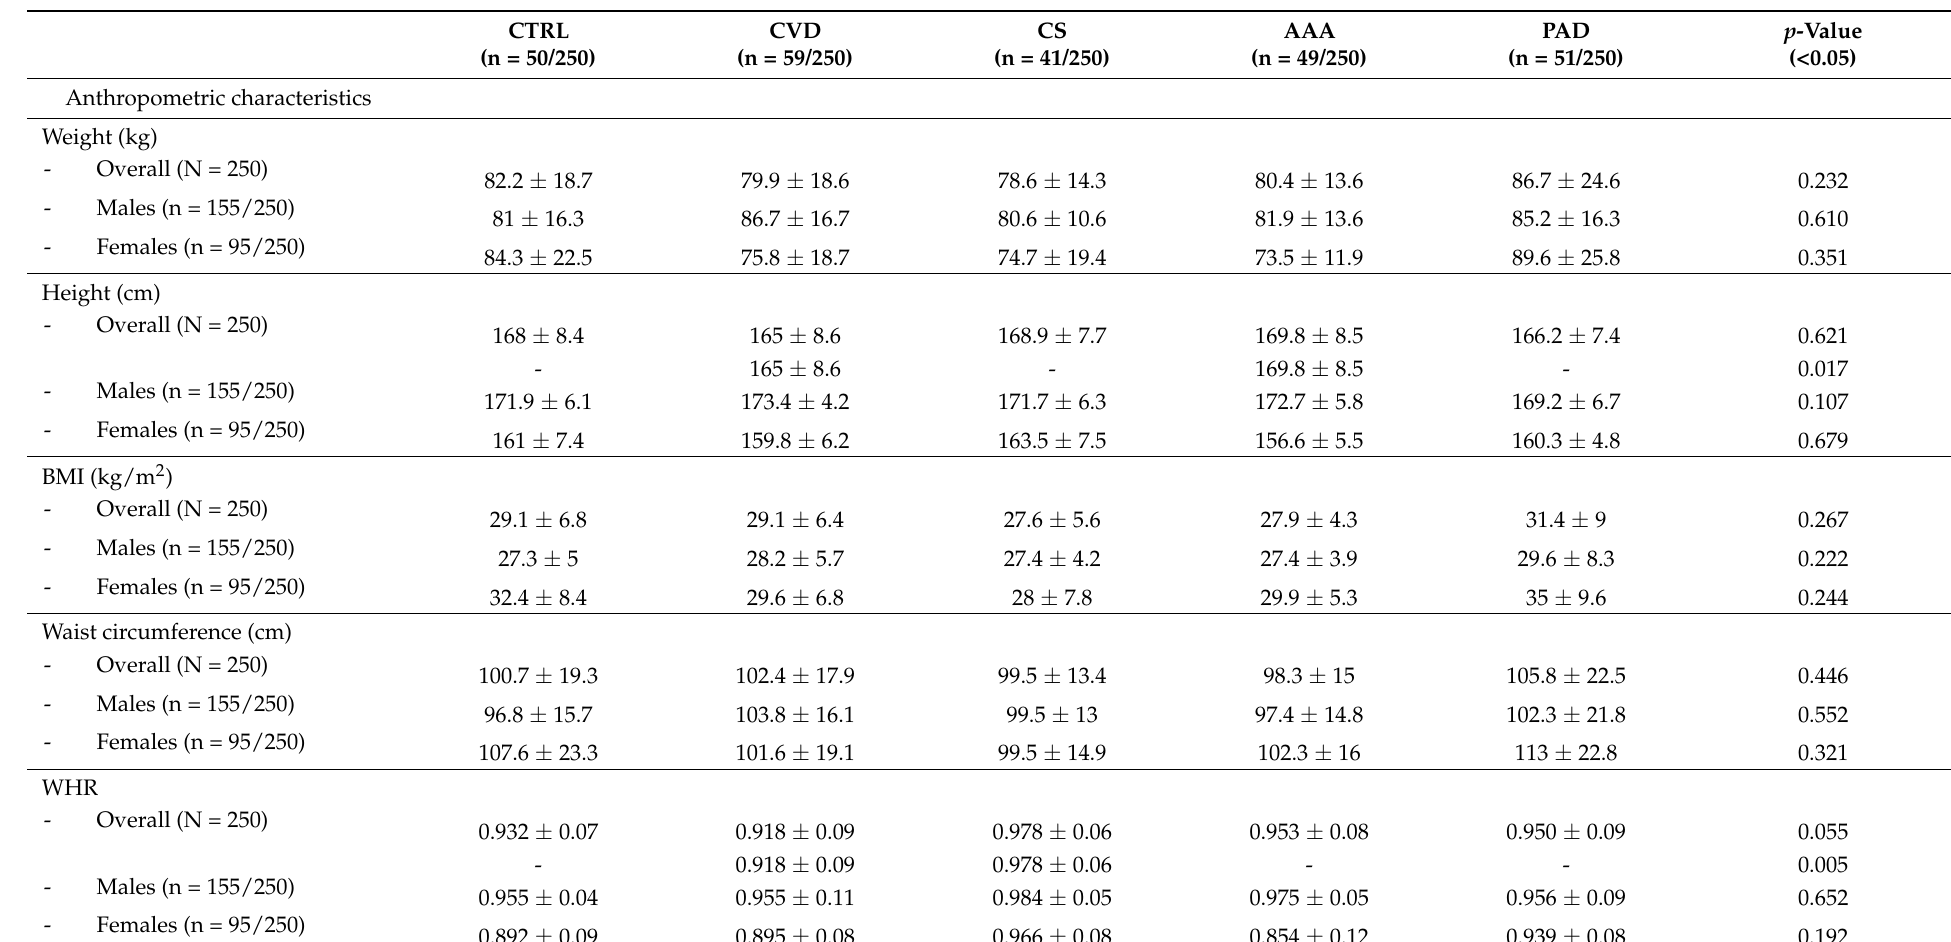
Table 2. Anthropometric